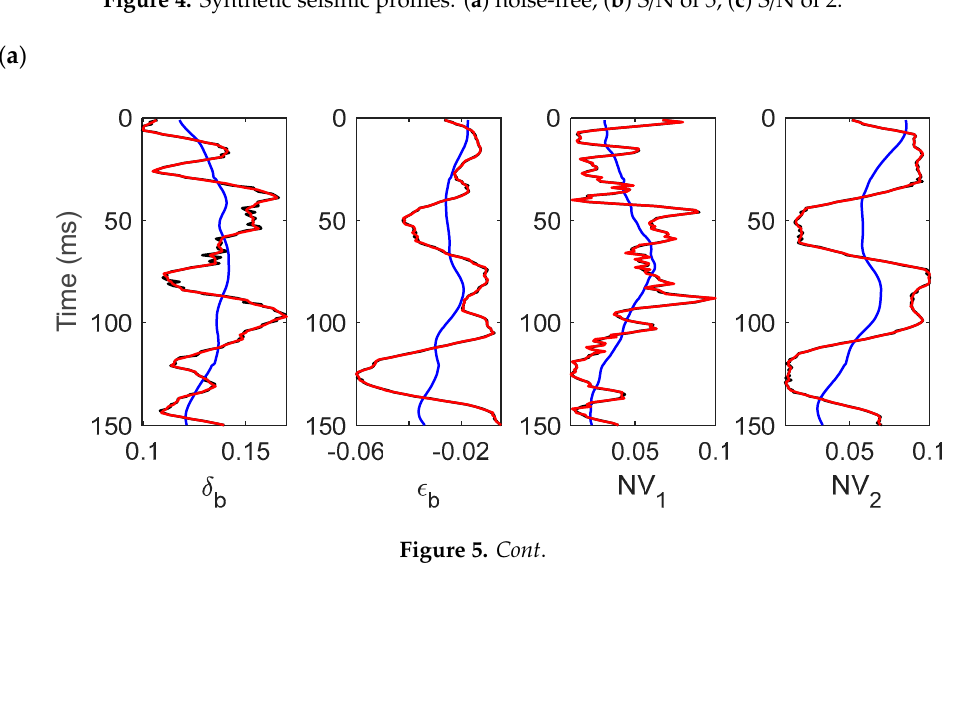
Figure 4. Synthetic seismic profiles. ( a ) noise-free, ( b ) S/N of 5, ( c ) S/N of 2.